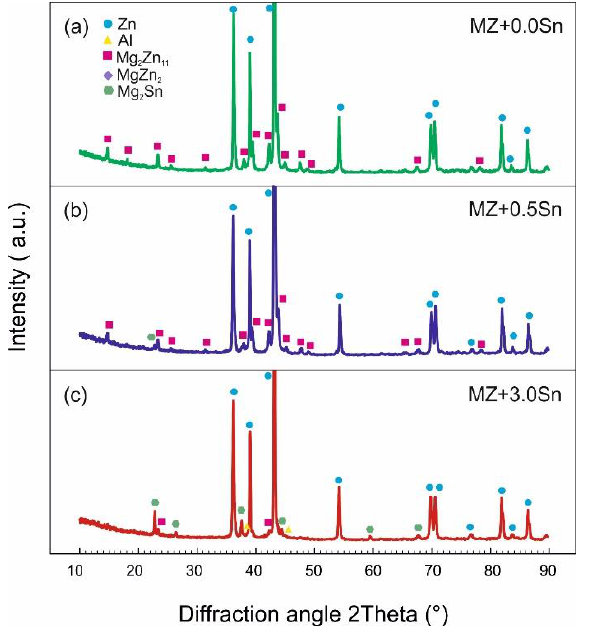
Figure 6. XRD diffraction patterns recorded on powder samples of selected alloys in annealed state ( a ) MZ + 0.0Sn, ( b ) MZ + 0.5Sn, ( c ) MZ + 3.0Sn.